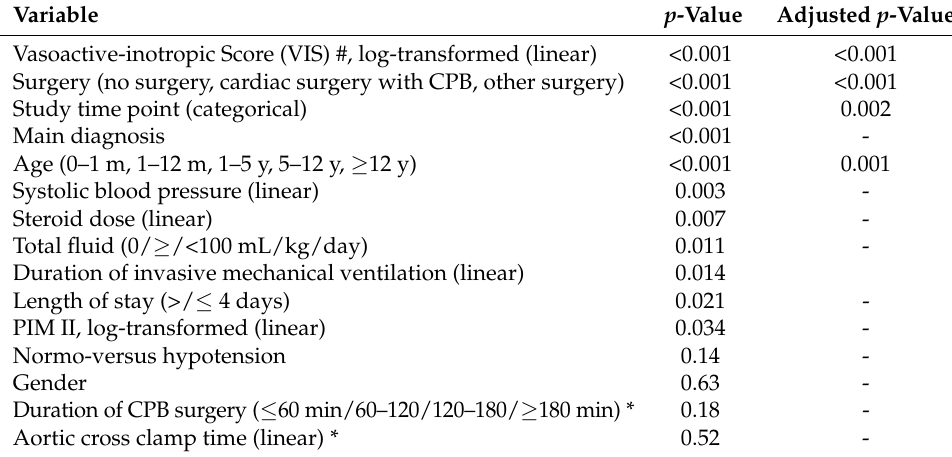
Table 2. Association of blood copeptin levels with clinical covariates in linear mixed-effect model ( p -value: likelihood ratio